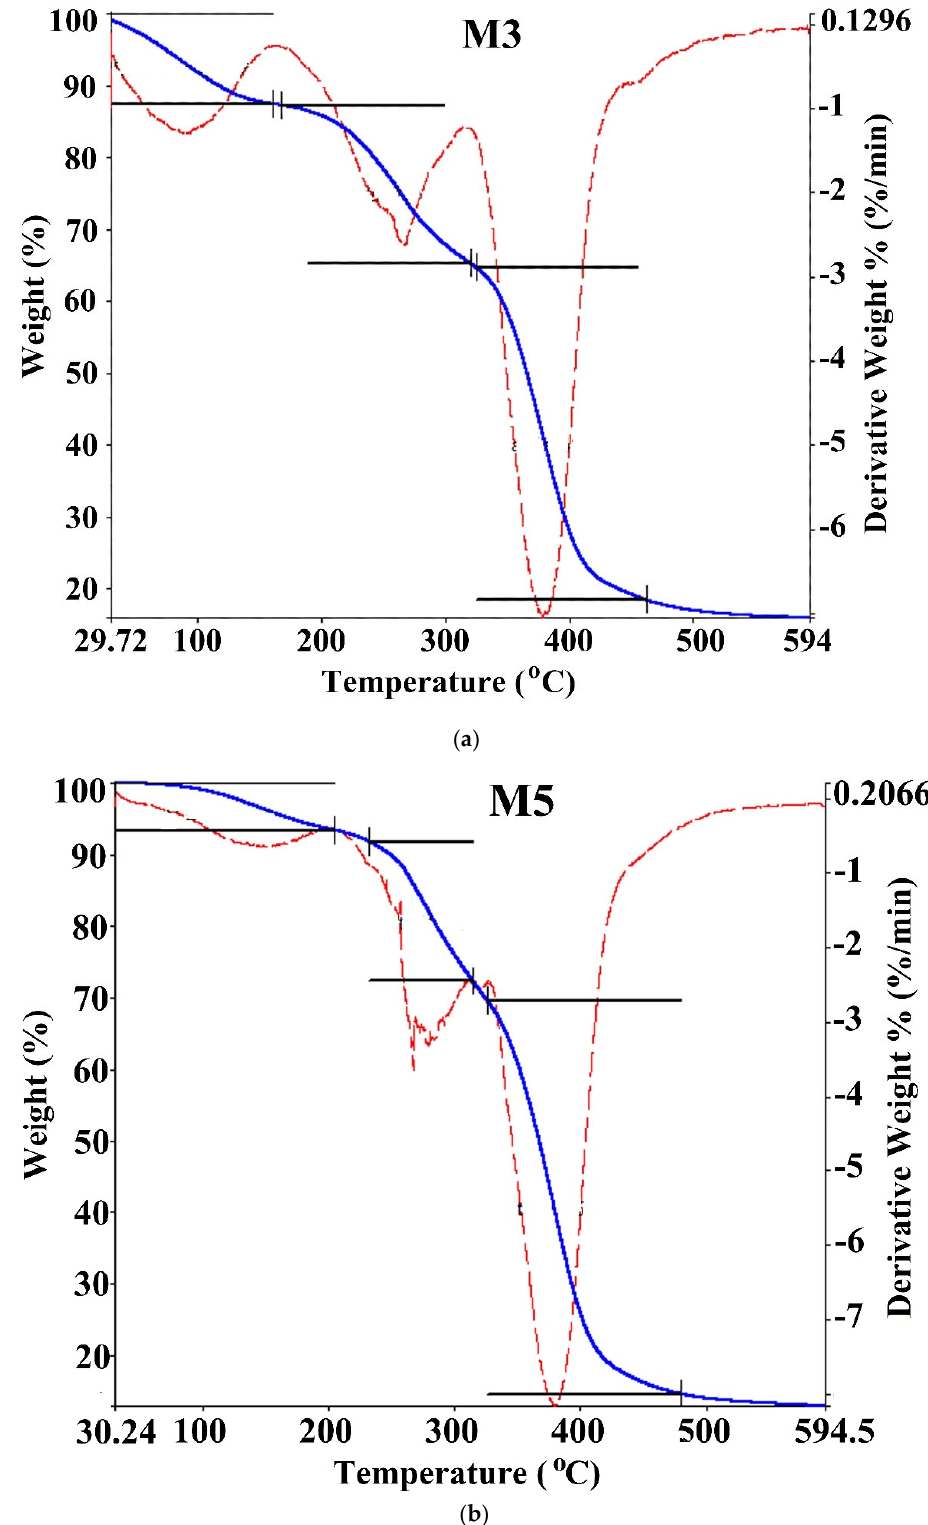
Figure 5. TGA curves of poly(DMA ‐ co ‐ AAc) hydrogel (( a ) for M3 and ( b ) for M5).